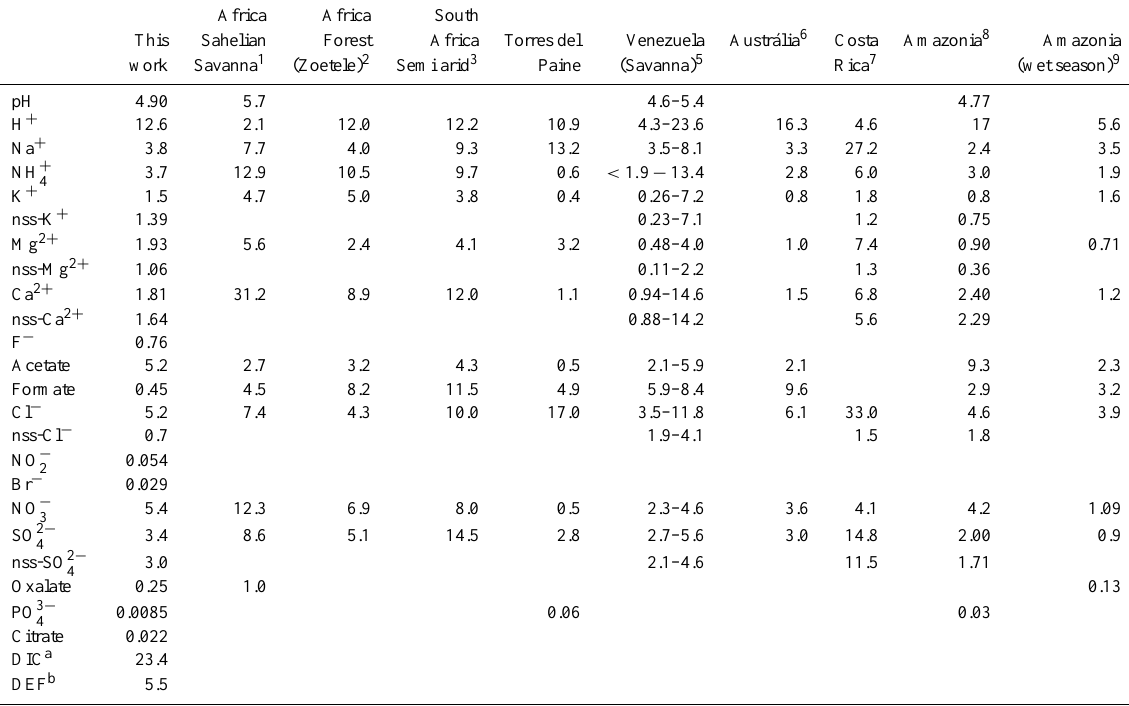
Table 4. Comparison of the rainwater chemistry results obtained in this study with other data from remote sites around the world. Values represent annual Volume Weighted Means expressed in µeql − 1 , except for DIC expressed in µml − 1